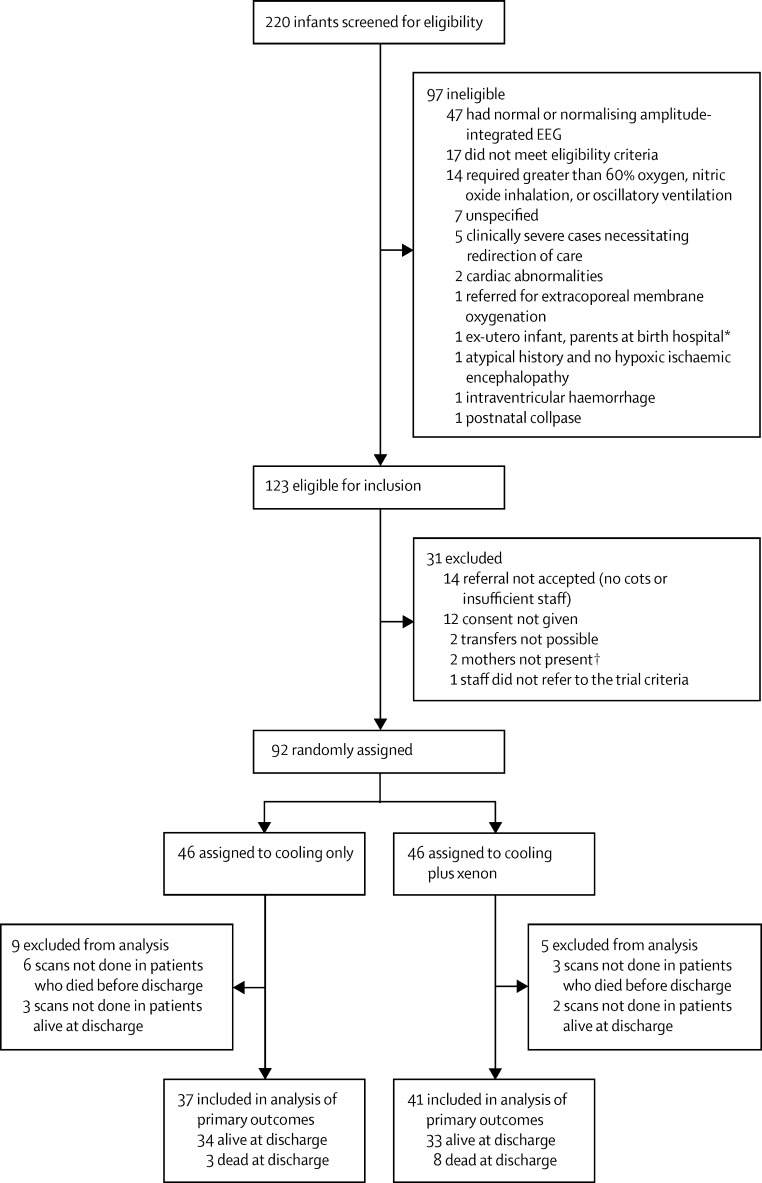
Trial profile*Could not give consent. †When parents were unmarried, only the mother of the infant could provide consent.